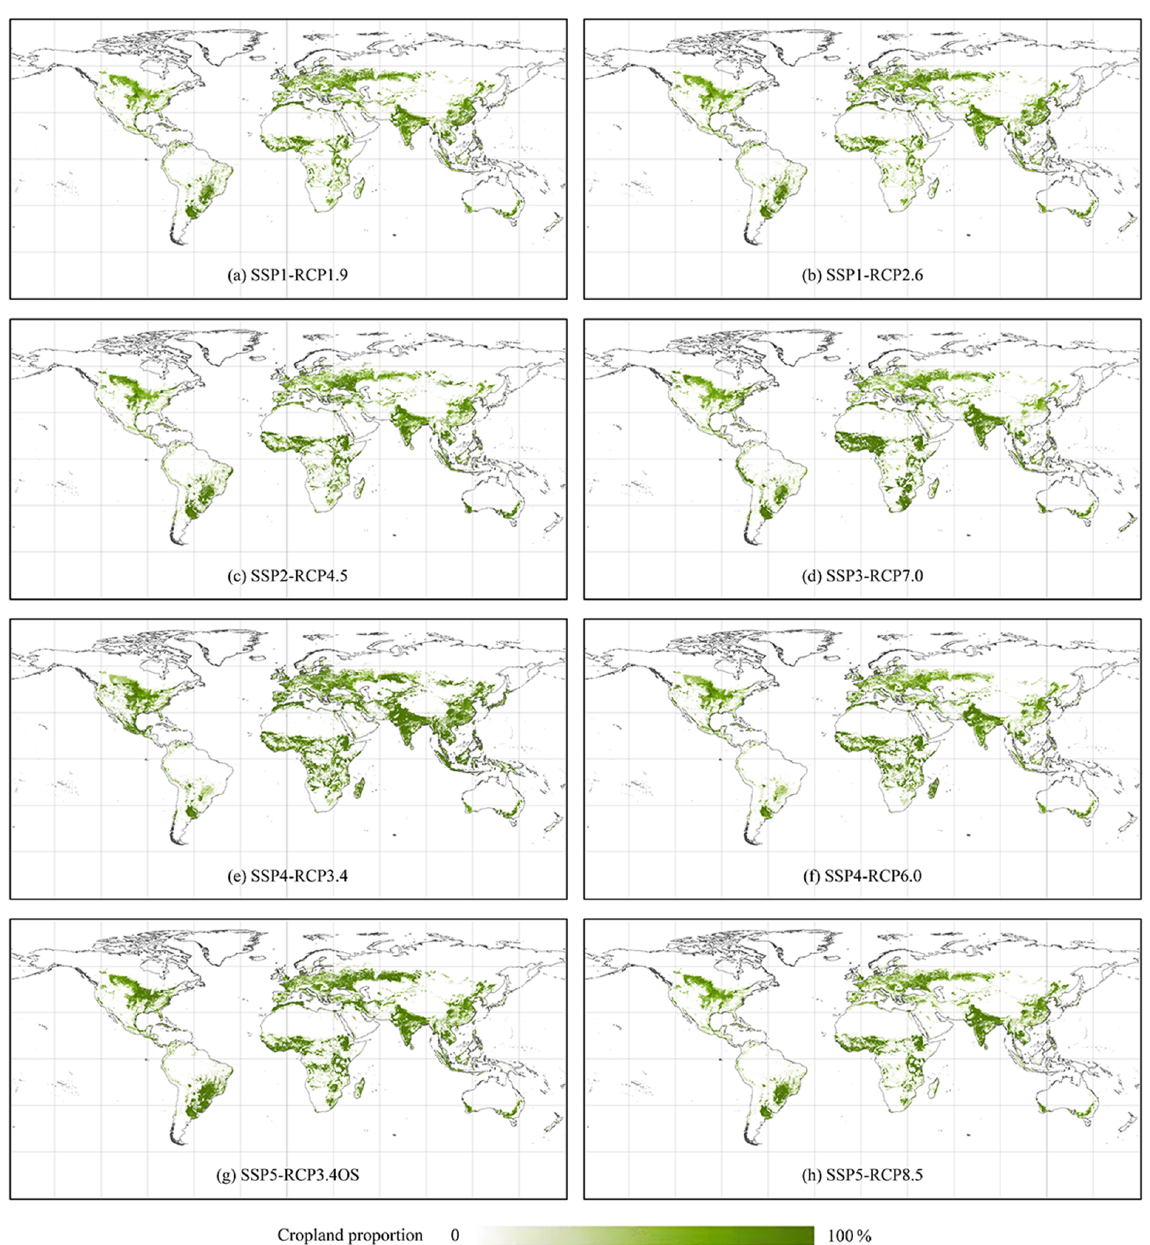
Figure 3. Downscaled future cropland maps in 2100CE under (a) SSP1-RCP1.9, (b) SSP1-RCP2.6, (c) SSP2-RCP4.5, (d)